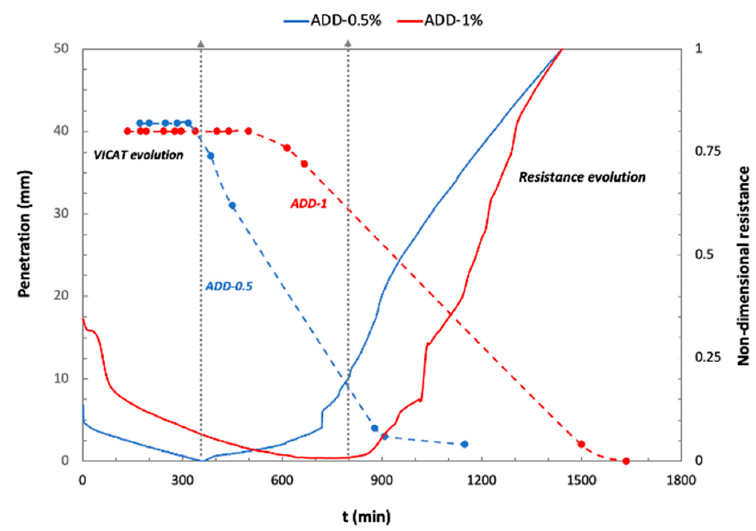
Figure 6. Comparison between needle penetration during VICAT test and electrical resistance evolution for the mortar with crystalline admixtures.